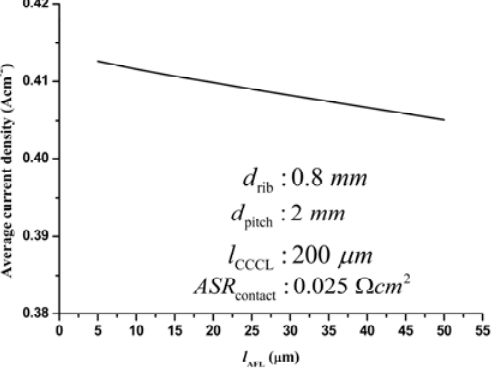
Figure 10. The variation of the average output current density with the AFL